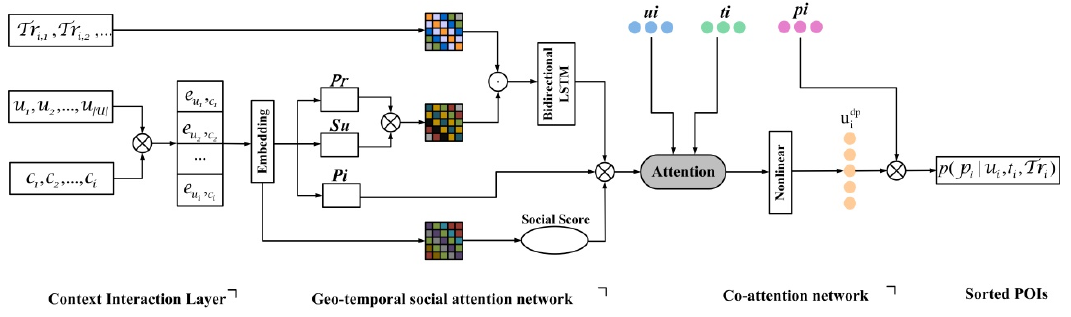
Figure 1. The Framework of CGTS-HAN Model.